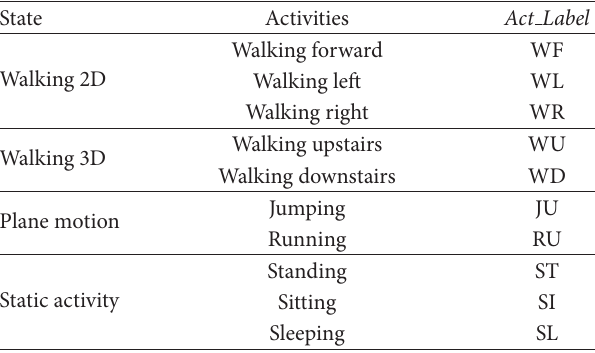
Table 1: Classified states and activities recognized in this study. State